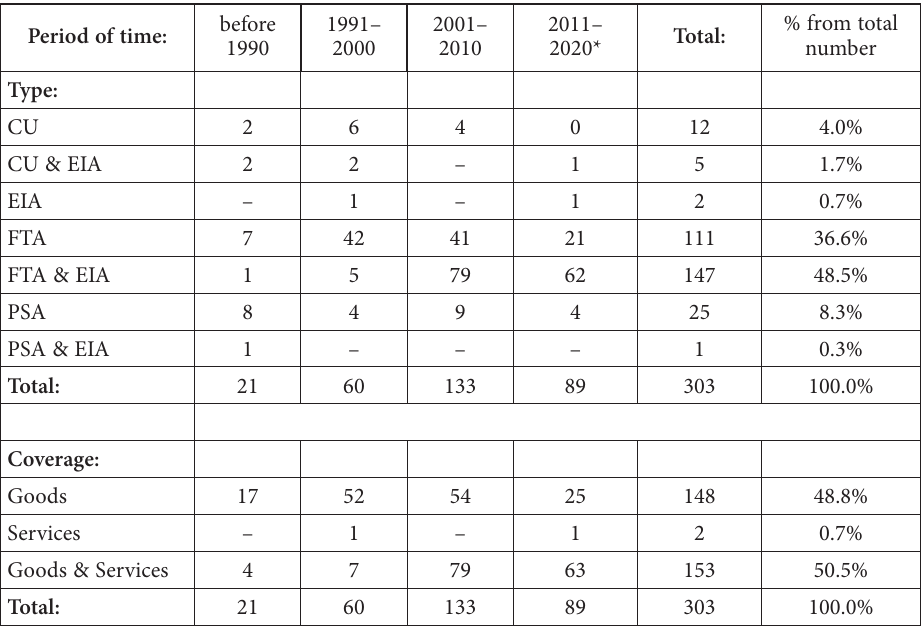
Table 1. Current regional trade agreements: their types and coverage, 1958–2020 (source: summed up by the authors based on World Trade Organization,